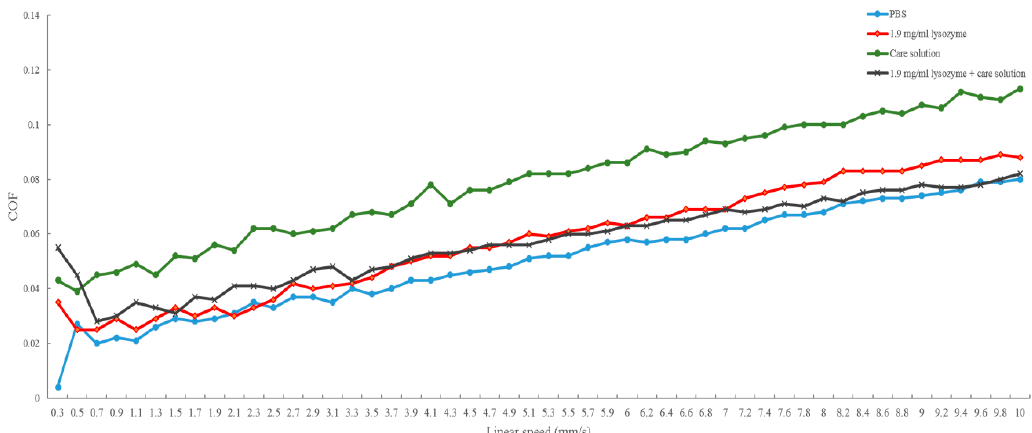
Figure 3. The comparison of the friction coefficient of different solutions for velocity variations. The friction coefficient of PBS (blue line), 1.9 mg/mL lysozyme solution (red line), γ -PGA-containing care solution (green line), and 1.9 mg/mL lysozyme and γ -PGA-containing care solution (black line) when velocity varies from 0.3 mm/s to 10 mm/s at normal load of 1 mN.